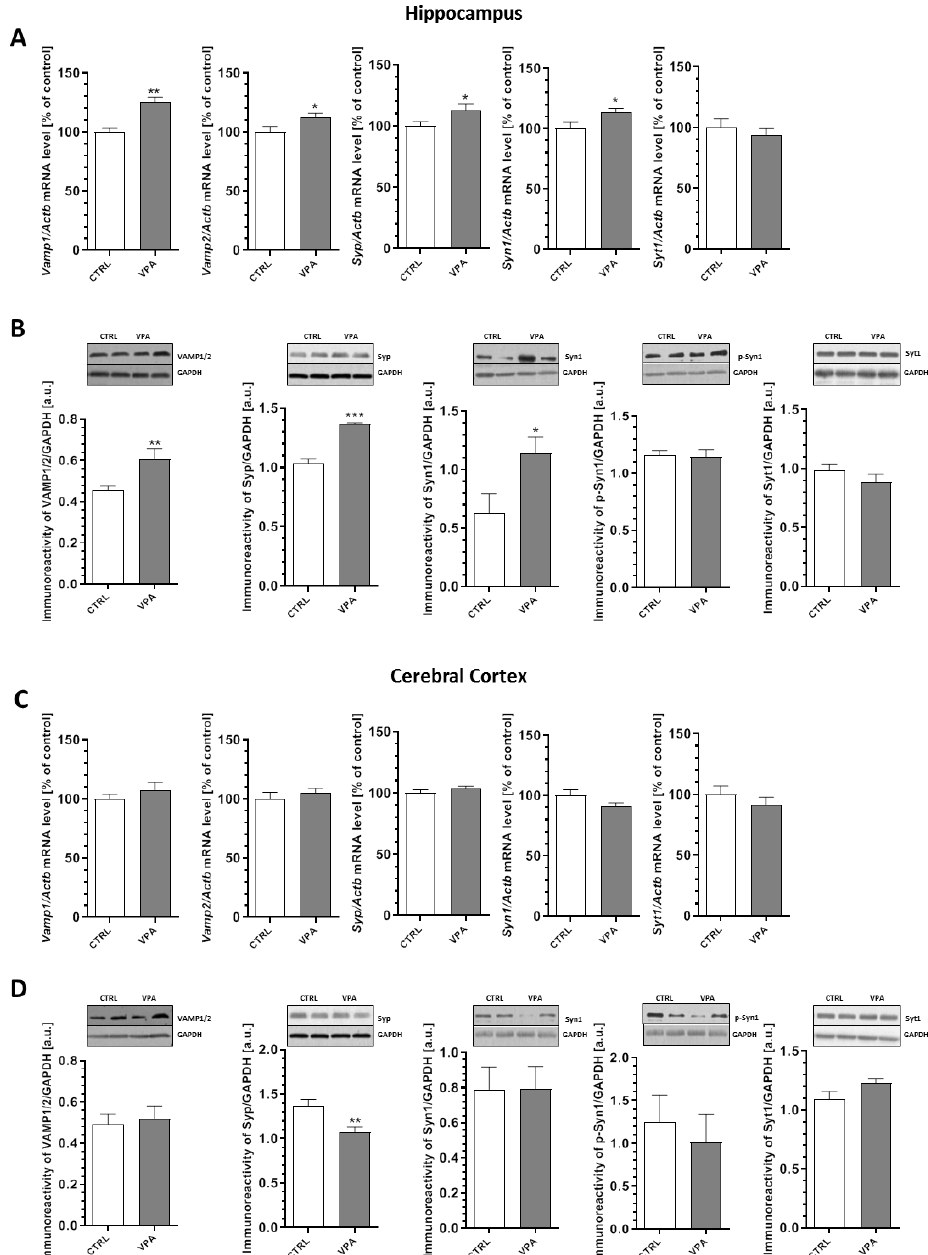
Figure 3. The effect of prenatal exposure to VPA on the expression of v -SNARE proteins: VAMP1/2, Syp, Syn1, p-Syn1(Ser62/Ser67), and Syt1. The level of mRNA of Vamp1, Vamp2, Syp, Syn1, and Syt1 in the hippocampus ( A ) and cerebral cortex ( C ) of the control and VPA-exposed rats is presented. The level of mRNA was measured by real-time PCR and calculated by the ΔΔCt method with Actb (β-actin) as a reference gene. The data represent the mean values ± SEM from n = (4–5) independent experiments in the hippocampus and n = (4–6) in the cerebral cortex. The immunoreactivity of the v -SNARE proteins in the control and the VPA-exposed rats was monitored using a Western blot analysis. Densitometric analysis and representative pictures of VAMP1 / 2, Syp, Syn1, p-Syn1, and Syt1 in the hippocampus ( B ) and cerebral cortex ( D ) are shown. Results were normalized to GAPDH levels. Data represent the mean values ± SEM from n = (3–9) independent experiments in both the hippocampus and cerebral cortex. * p < 0.5, ** p < 0.01, *** p < 0.001 vs.